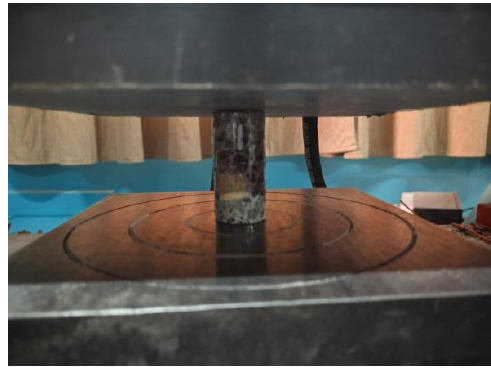
Figure 4. Loading diagram of specimen.